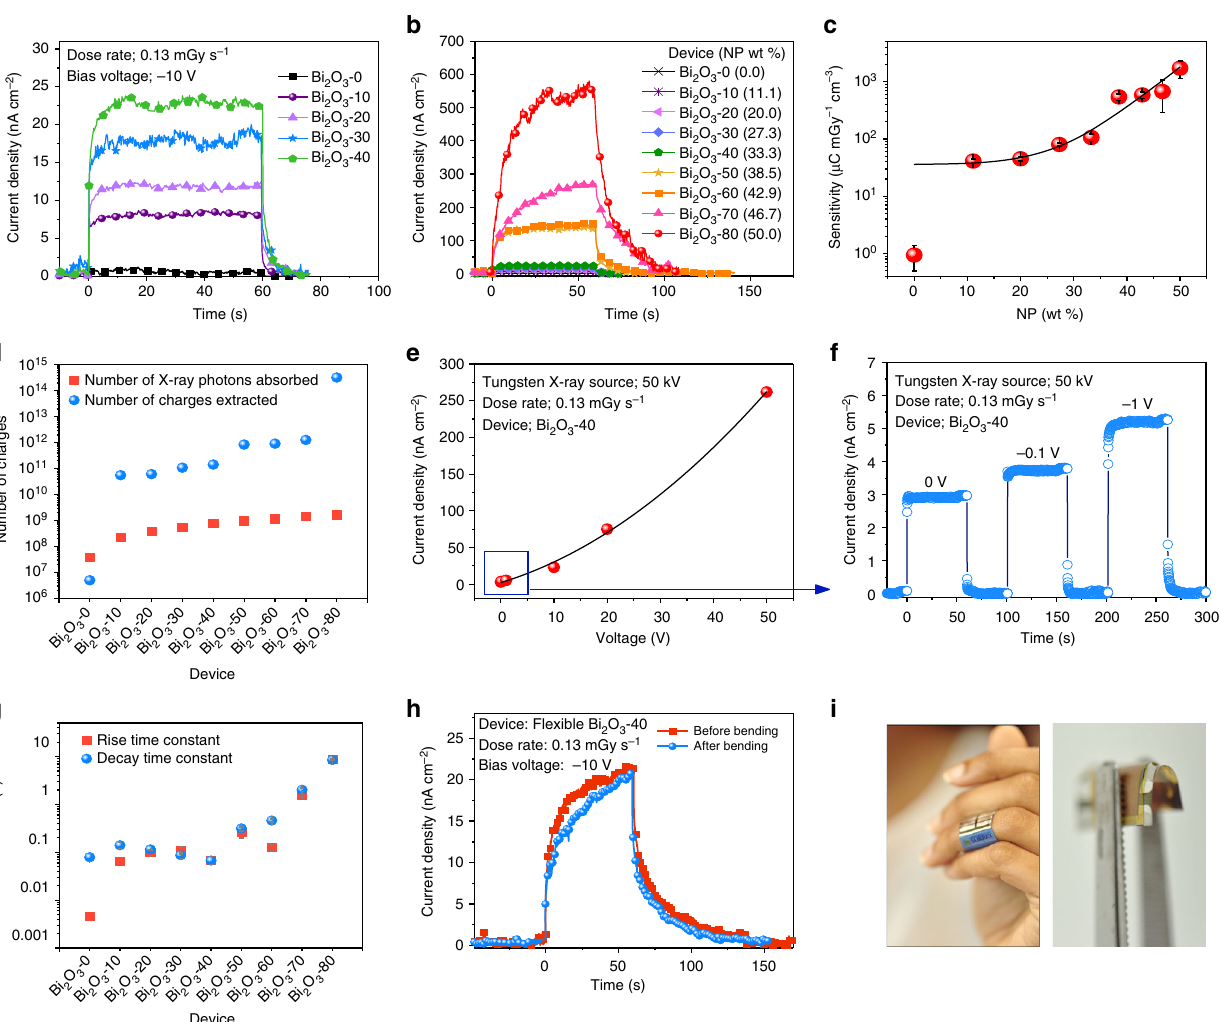
Fig. 2 Detector performance under X-ray irradiation. a X-ray photocurrent densities for devices with different Bi 2 O 3 loadings from Bi 2 O 3 -0 to Bi 2 O 3 -40 and b from Bi 2 O 3 -0 to Bi 2 O 3 -80. c Averaged sensitivity values for six devices and the error bars represent the range of the sensitivity values. d Comparison between number of X-ray photons absorbed by each device and the number of charges extracted. e The voltage dependence of the Bi 2 O 3 -40 device, f X-ray photocurrent response of the Bi 2 O 3 -40 detector under 0, − 0.1 and − 1 V biases. g Rise and decay time constants (the error bars represent the standard error shown with respect to the fi tted curves) for detectors with increasing Bi 2 O 3 loadings under − 10 V bias. h X-ray photocurrent response before and after bending for a fl exible Bi 2 O 3 -40 device. i A prototype X-ray detector integrated into a plaster and detector bend radius (0.3